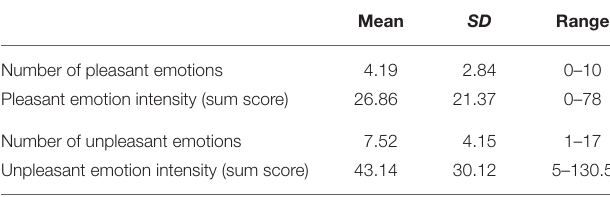
TABLE 2 | Number of emotions and extent of emotional